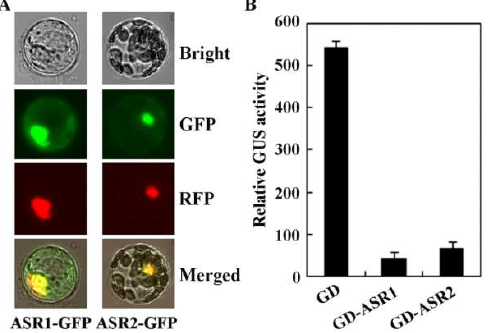
Figure 2. Sub-cellular localization and transcriptional activities of ASR1 and ASR2. ( A ) Sub-cellular localization of ASR1 and ASR2. Plasmids of ASR1-GFP and ASR2-GFP were co-transfected, respectively, with the nuclear marker gene NLS-RFP into isolated Arabidopsis protoplasts, the transfected protoplasts were incubated for 18–22 h under darkness at room temperature, then the GFP and RFP florescence was observed under a florescence microscope and pictures were taken. ( B ) Transcriptional activities of ASR1 and ASR2. Plasmids of GD-ASR1 and GD-ASR2 were co-transfected, respectively, with LD-VP activator and the LexA-Gal4 : GUS reporter constructs into isolated Arabidopsis protoplasts, the transfected protoplasts were incubated for 18–22 h under